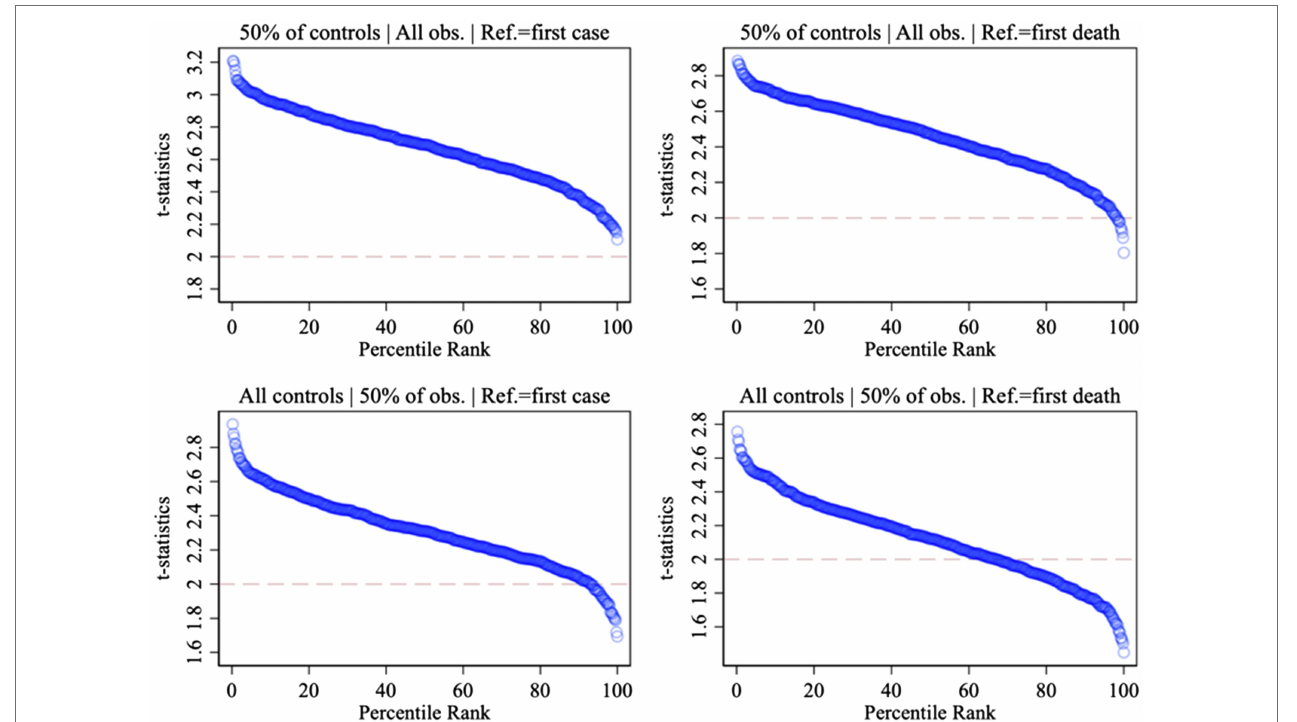
FIGURE 3 | Model dependence: 2,000 test statistics and percentile ranks.